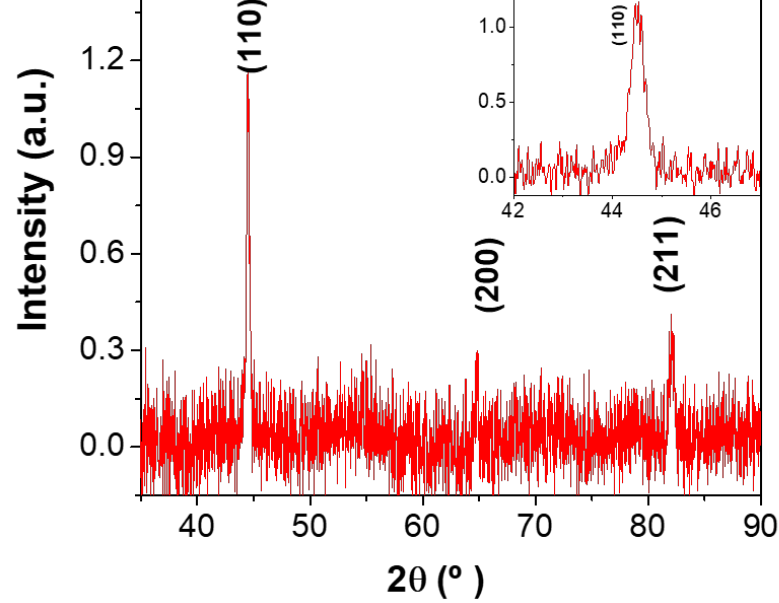
Figure 2. X-ray diffractometry (XRD) pattern of an electrodeposited Fe NW array. The inset shows a magnified view of the XRD pattern around the (110) crystallographic peak.